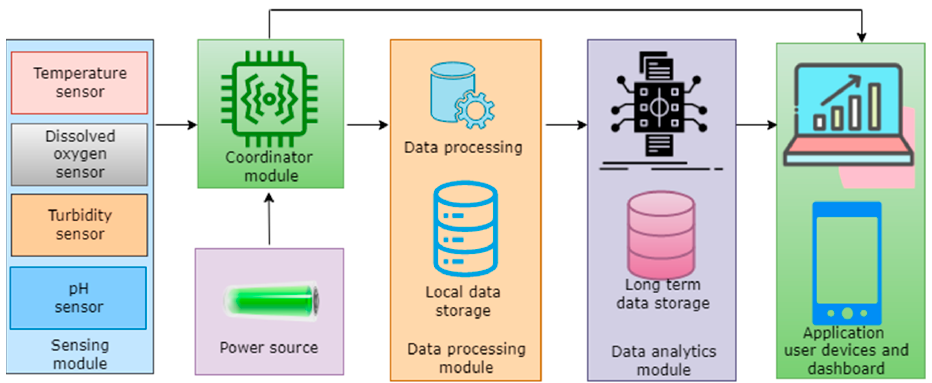
Figure 1. A typical example of internet of water things.